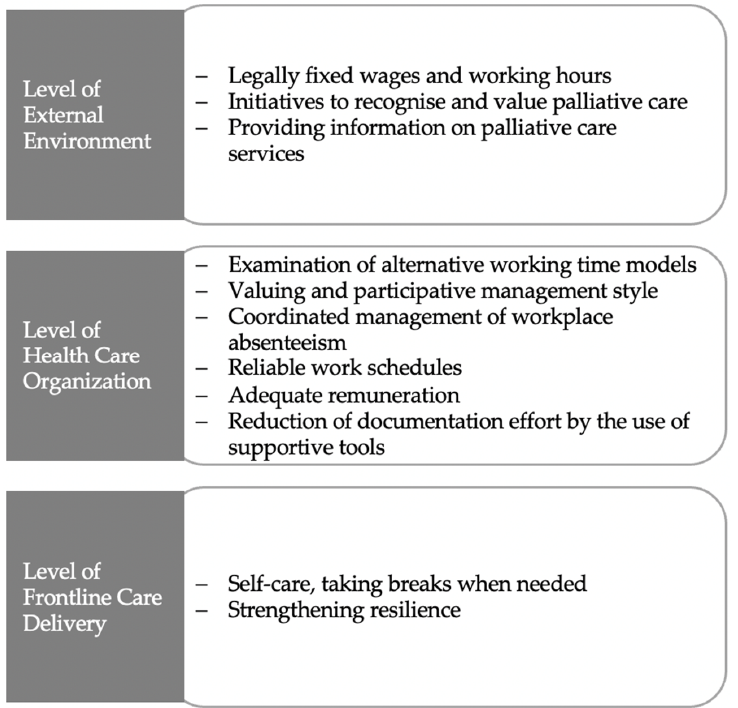
Figure 6. Interventions that could target burden among palliative care nurses.